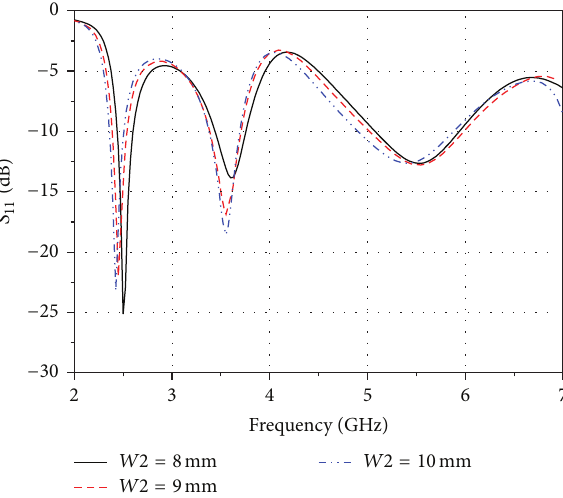
Figure 2: Effects of the parameter 𝑊2 on the return